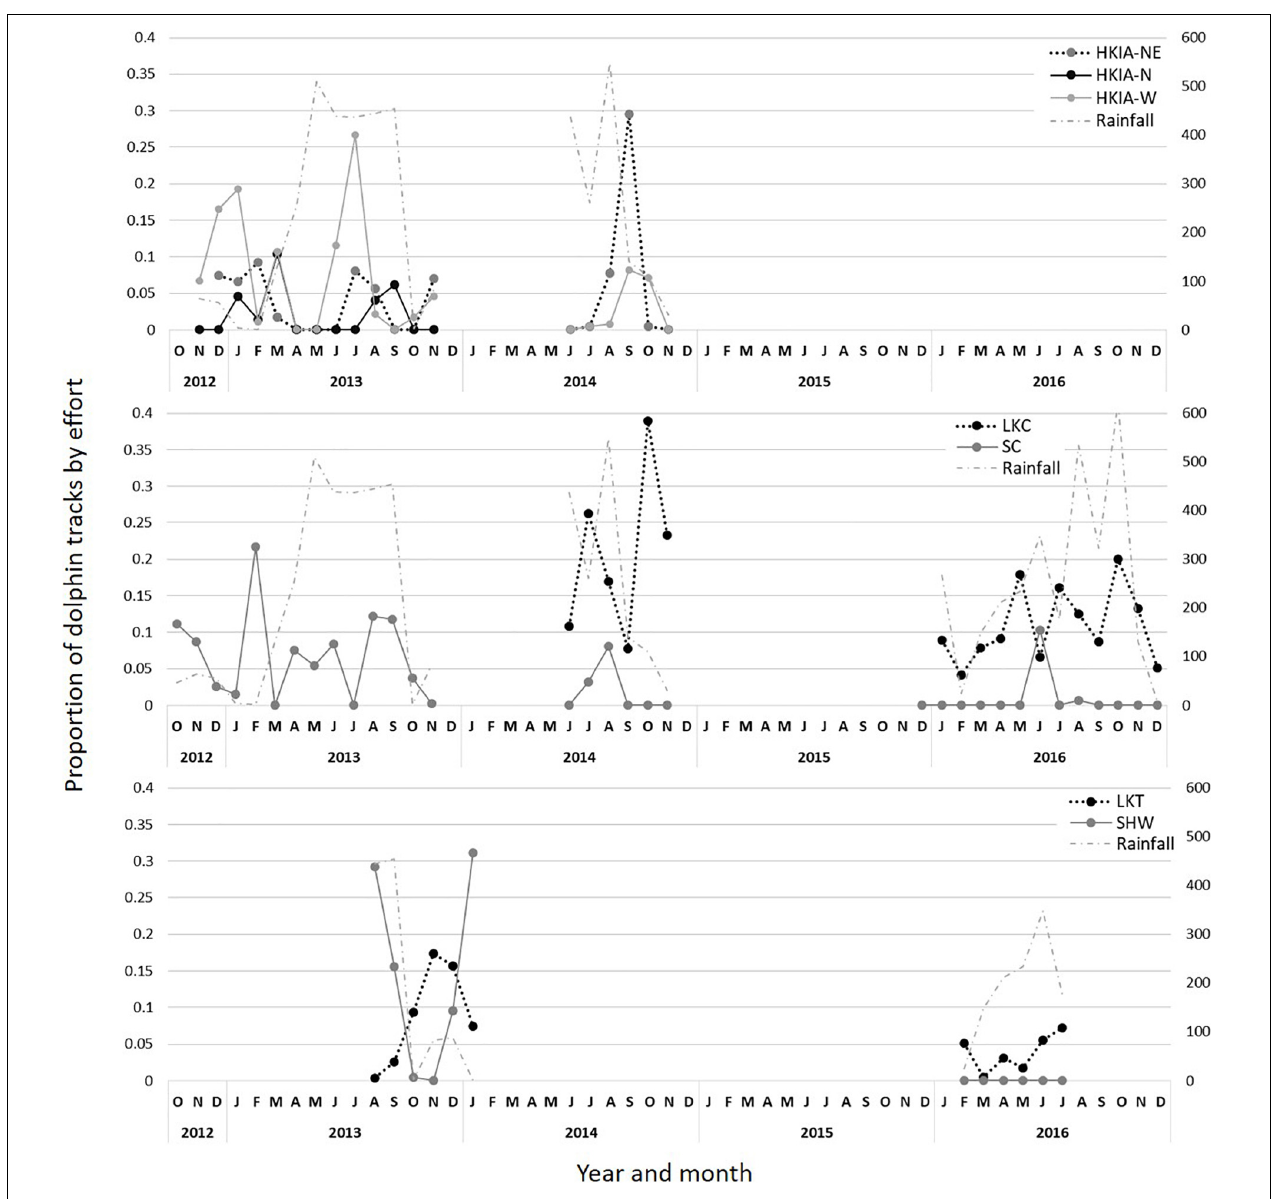
FIGURE 2 | Proportion of Indo-Pacific humpback dolphin track duration standardized by on-effort survey time. Figure includes year, month, and rainfall for each land-based location. Months with no points indicate zero effort.